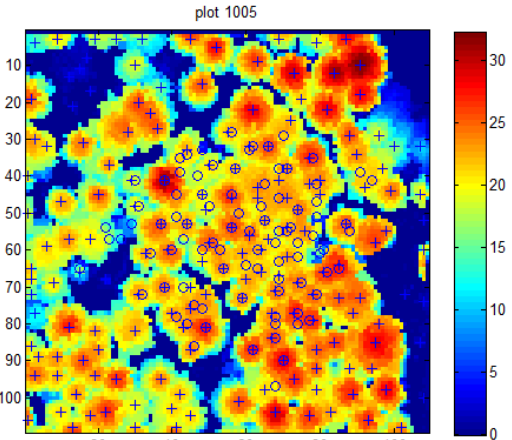
Figure 8. Individual tree detection for one of the plots.